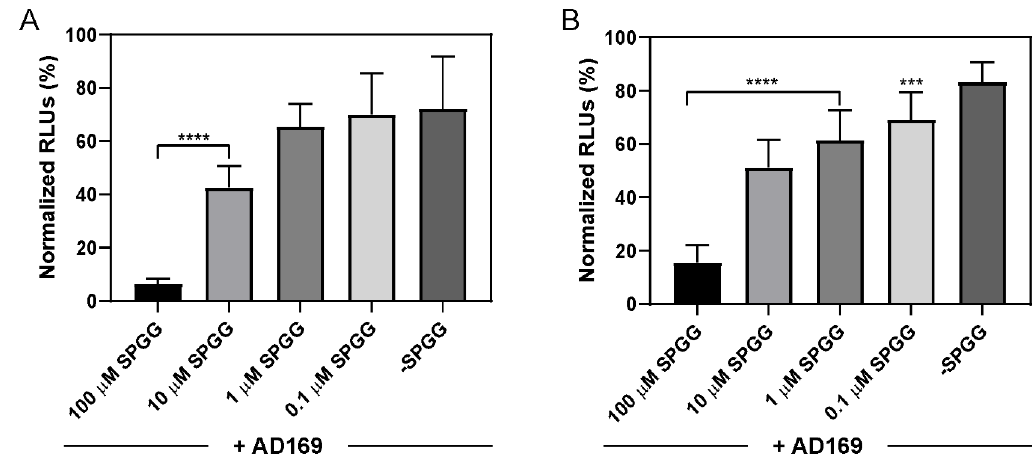
Figure 4. HCMV immediate early (IE) gene 1 and 2 expression in ( A ) HFF-1 cells and ( B ) SK-N-MC cells in the presence of SPGG. In this cell-ELISA experiment, HFF-1 ( A ) or SK-N-MC ( B ) cells were challenged with HCMV (0.3 multiplicity of infection (MOI)) pre-treated with SPGG or mock and an antibody against immediate early (IE) genes. The graphs reveal a SPGG-dose-dependent decreased expression of IE both in HFF-1 and SK-N-MC cell line, respectively. ANOVA determined significant differences among means with a P -value of < 0.0001 in both ( A ) and ( B ). Further analysis using Dunnett’s multiple comparison test found significance of decreased expression when compared to the mean of the control column, (****) signifies a P -value of < 0.0001 and (***) signifies a P -value of 0.0002. The graphs result from mean values and SDs of experiments, each condition was tested in triplicate at N of 5.